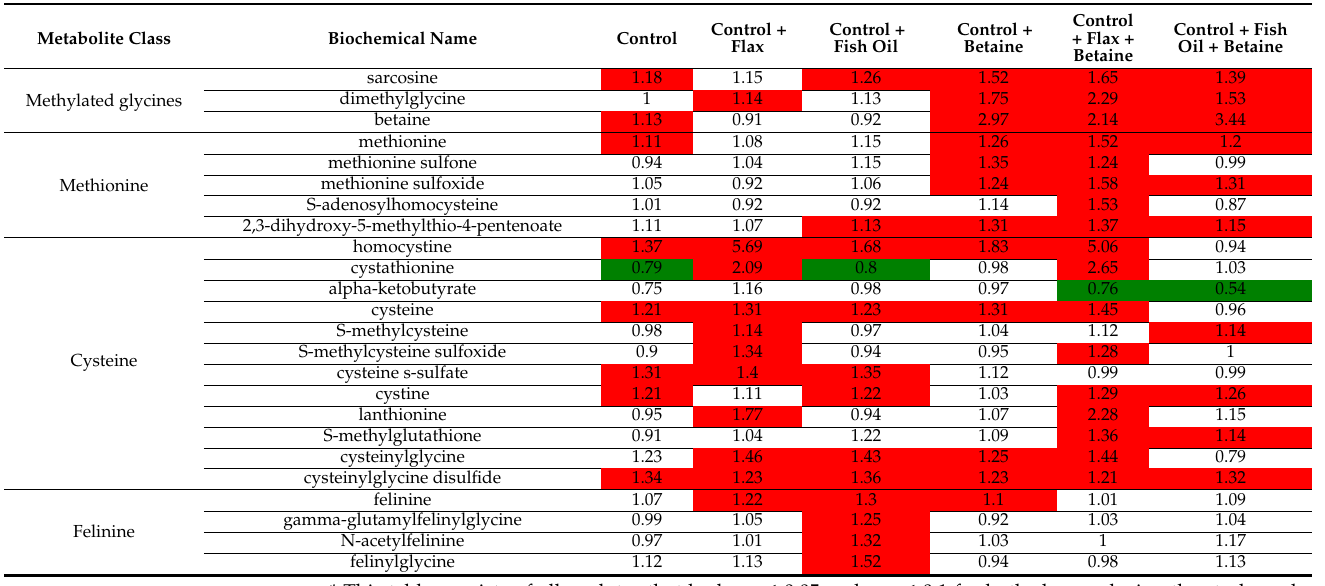
Table 5. Methylated glycines and sulfur amino acid metabolites which changed during the study while consuming control, or betaine, flax, and fish oil supplemented foods *.